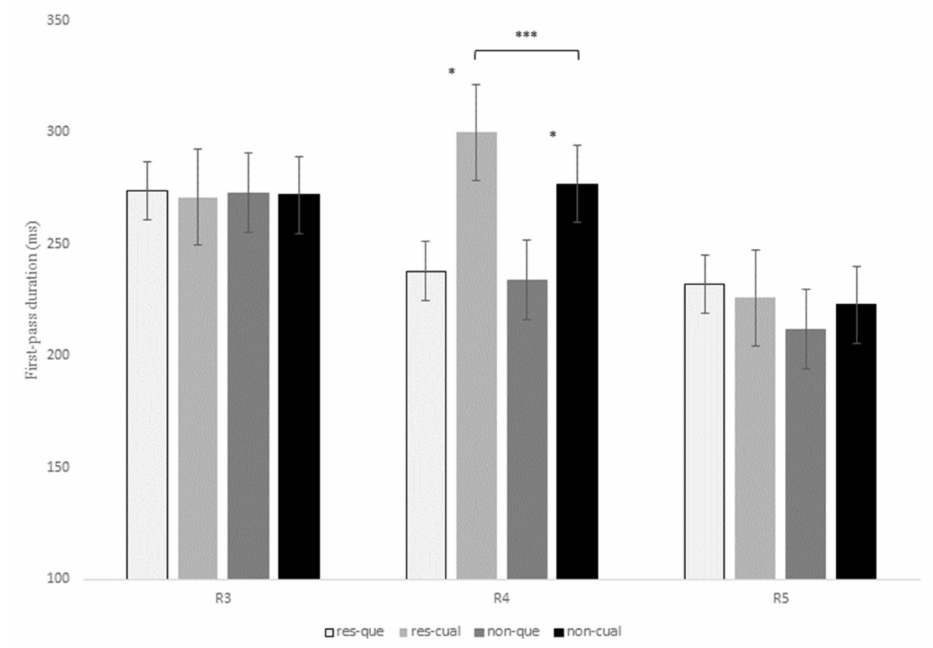
Figure 2. Reading time in milliseconds for first-pass duration at regions 3, 4, and 5 for the contrast que versus el cual in restrictive and non-restrictive RCs. Asterisks indicate that an effect is significant at the following alpha levels: * = p < 0.05; *** = p < 0.001.